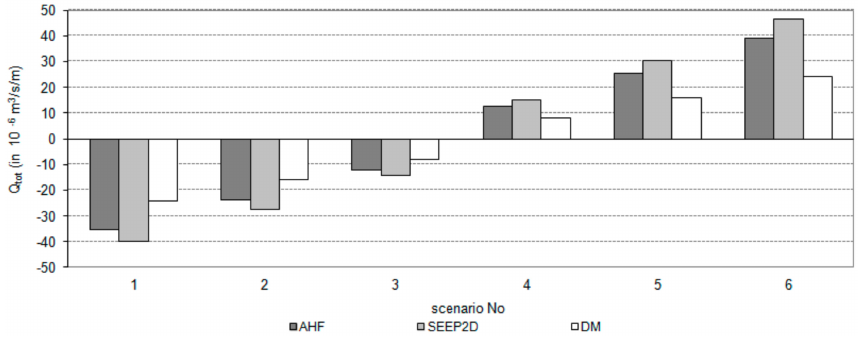
Figure 6. River recharge / discharge by groundwater seepage for di ff erent scenarios and models. Negative values of the river seepage indicate that the river is of water-gaining type; positive values occur when the river is of